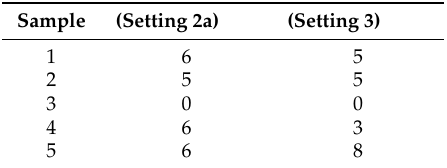
Table 11. Number of variables whose reconciled value is out of the confidence region of